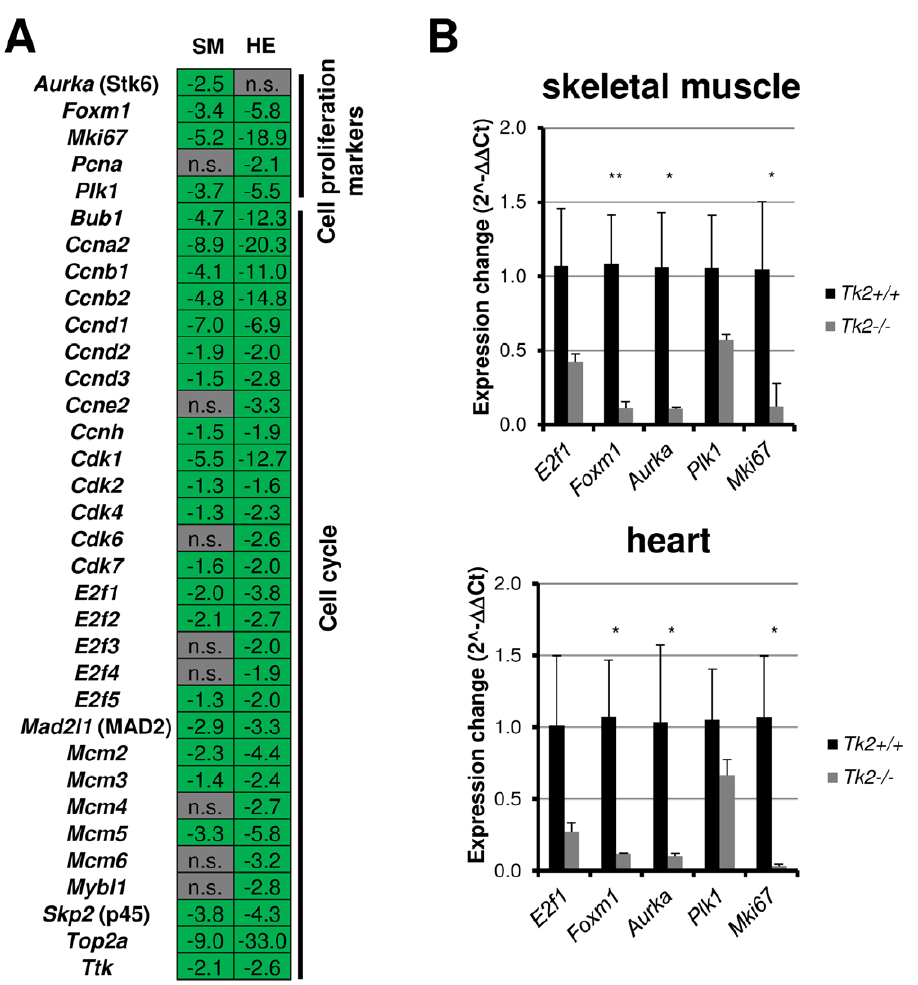
Figure 4. Cell cycle and cell proliferation related genes expression variation in both skeletal muscle and heart of 11 days-old Tk2 knockout ( Tk2 2 / 2 ) mice. A ) Gene variation obtained by microarray analysis. SM and HE refer to each of the gene expression analyses made, in skeletal muscle and in heart. n.s . indicates that the gene is not significantly up- or down-regulated in the analysis. B ) Expression of some genes was also analysed by Real-time qPCR. The P -values for statistical comparisons (two-tailed unpaired Student’s t-test) between Tk2 + / + and Tk2 2 / 2 tissues are shown - * P , 0.05; ** P , 0.01.